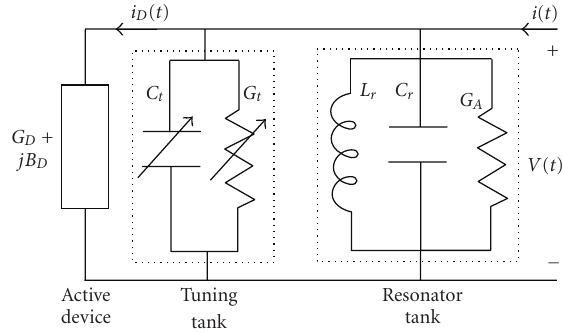
Figure 1: The equivalent circuit of the oscillator in the current-sum